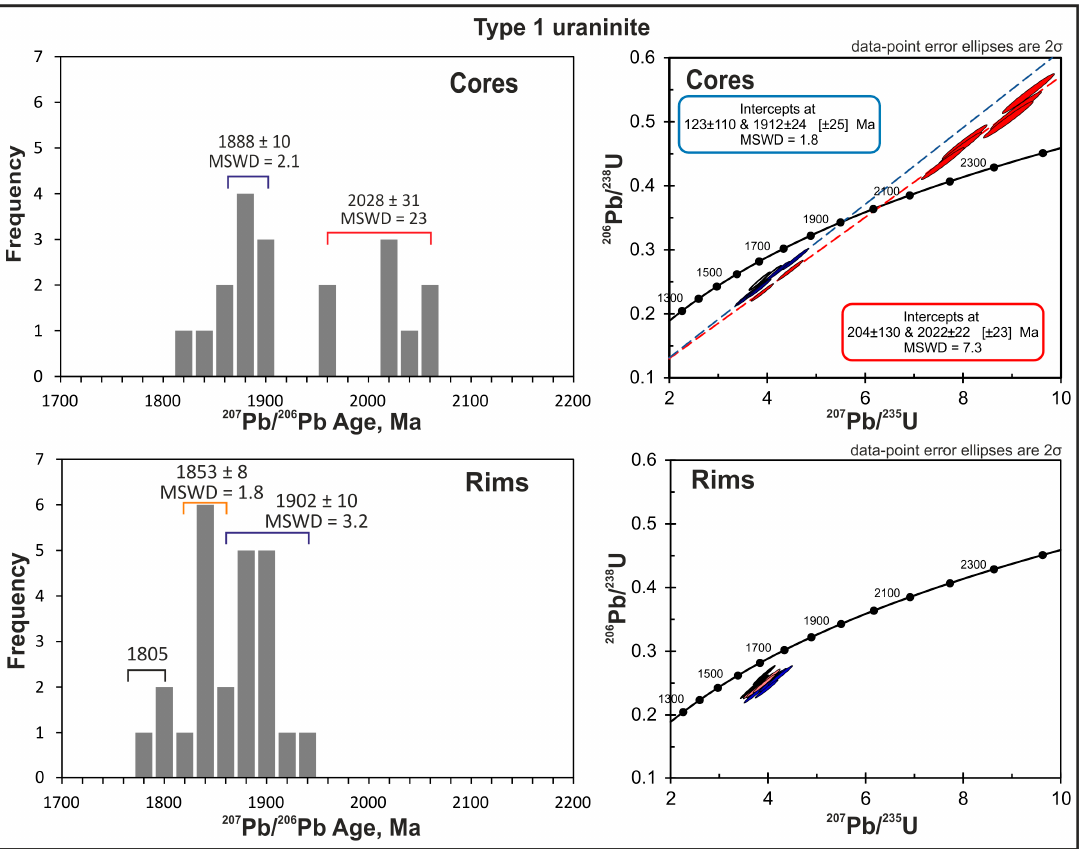
Figure 4. Frequency distribution diagrams for 207 Pb/ 206 Pb ages and Wetherill concordia diagrams for the cores and rims of Type 1 uraninite. Black ellipses on the Wetherill diagrams mark data which were excluded from the regression of discordia lines.